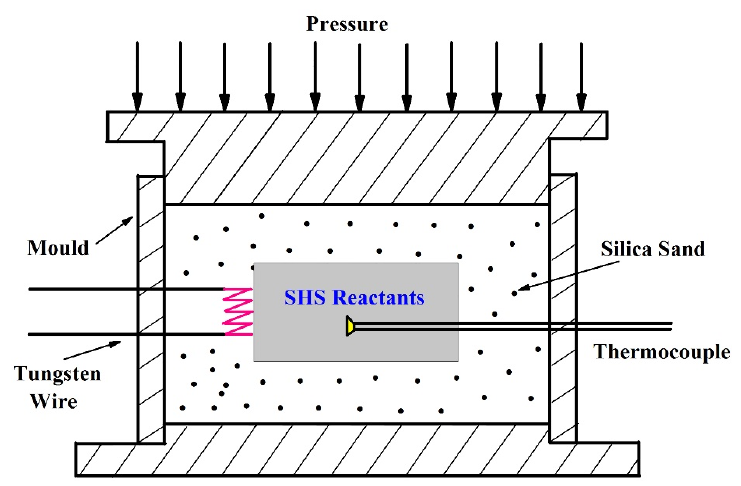
Figure 1. Diagrammatic sketch of the self-propagating high-temperature synthesis/quick pressing (SHS/QP) process.